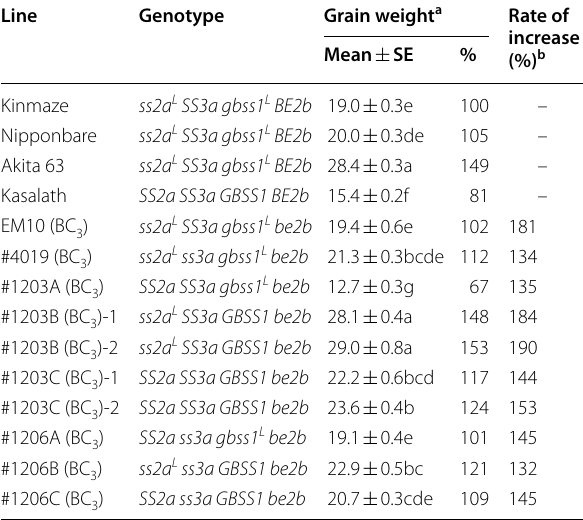
Table 1 Genotypes of rice lines used in this study, and their grain weight-related